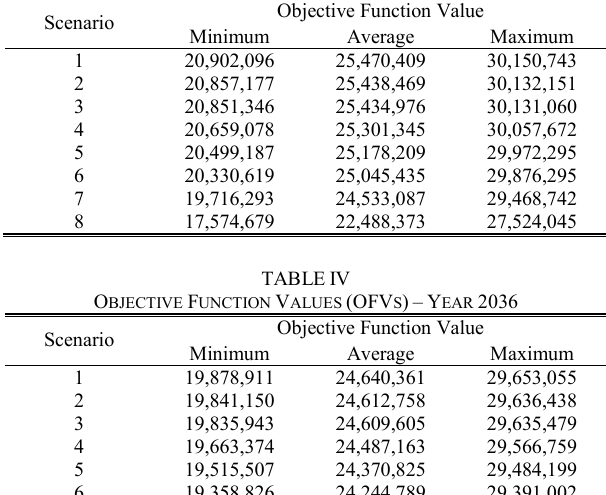
TABLE III O BJECTIVE F UNCTION V ALUES (OFV S ) – Y EAR 2026